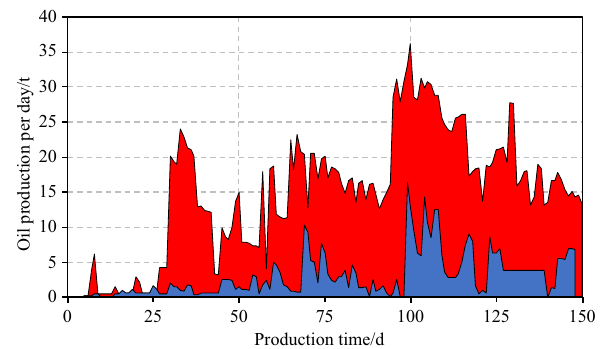
Fig. 21 Oil production per day of the two infill wells